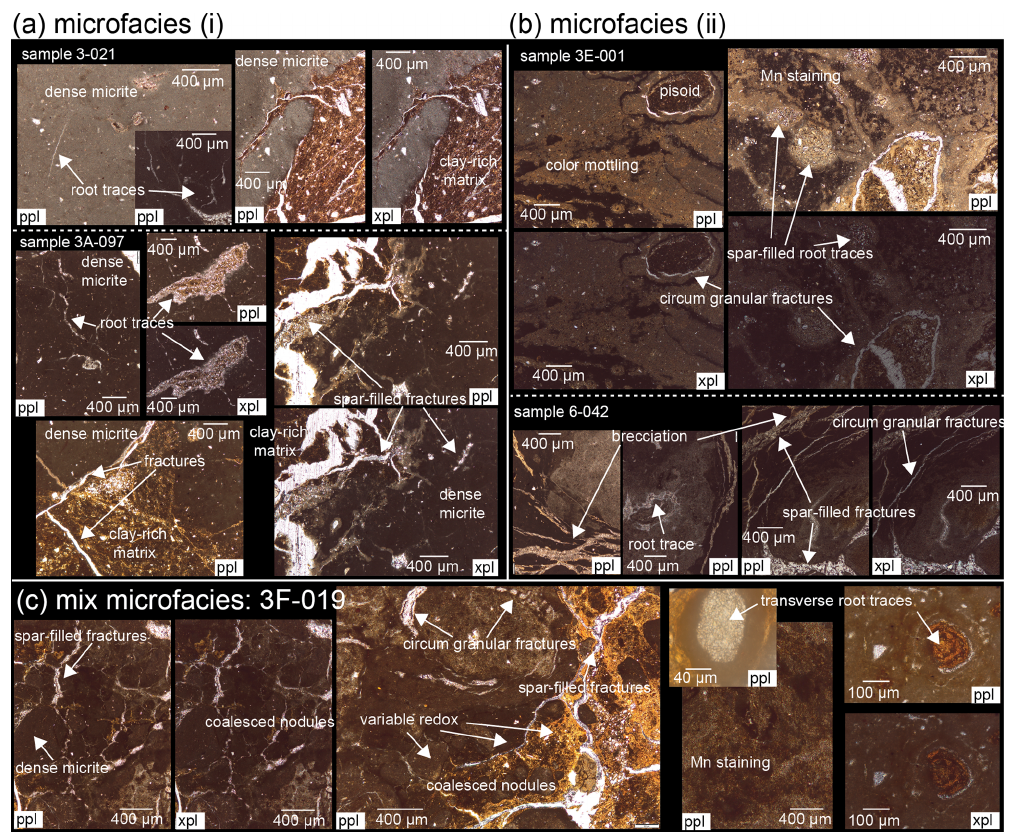
Figure 2. Annotated photomicrographs from select carbonate nodules of the White Pagoda Site. Samples are split into two microfacies (a, b) with sample 3F-019 appearing to be a mixture of the two microfacies (c) . Table 1. Primary carbonate stable isotope data measured at KU ( δ 13 C and δ 18 O) for the White Pagoda Site. (cid:49)δ 13 C calculated with δ 13 C org of Suarez et al.